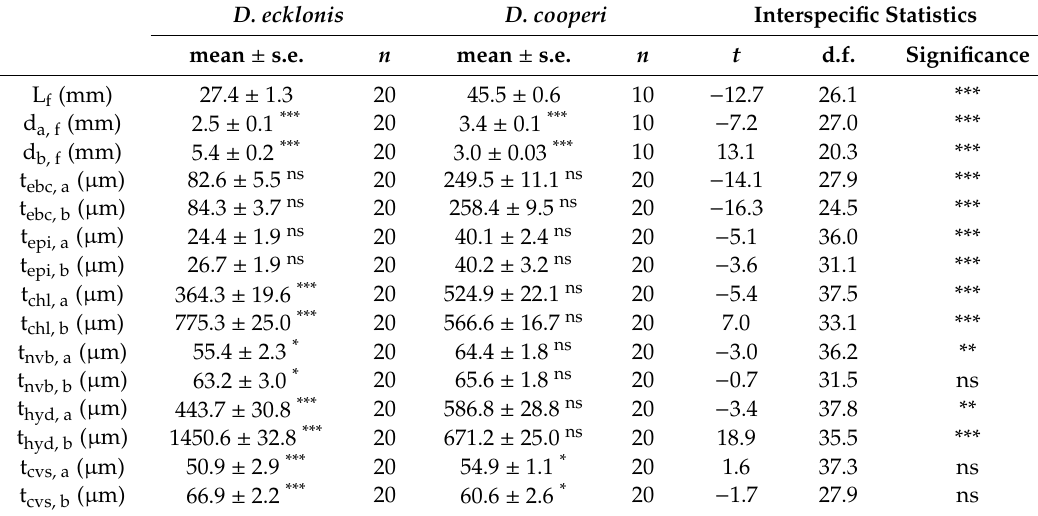
Table 1. Morphometric data of the leaves of D. cooperi and D. ecklonis , showing the mean and the standard error (s.e.) of the total leaf length (L), the leaf diameters (d) a and b for fresh leaves (f) and the tissue thicknesses (t) of the epidermal bladder cells (ebc), the epidermis (epi), the chlorenchyma